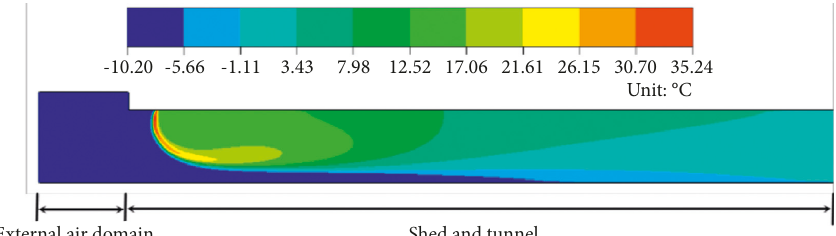
Figure 8: Cloud diagram of tunnel temperature